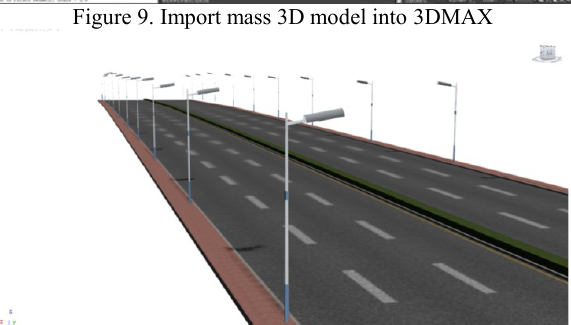
Figure 9. Import mass 3D model into 3DMAX